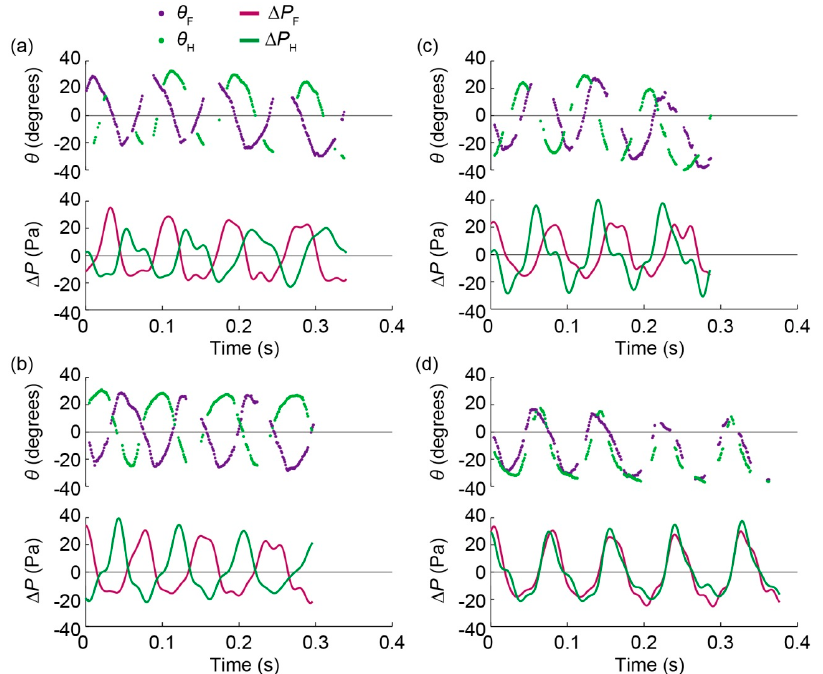
Figure 11. Flapping angles and differential pressures of forewing and hindwing for the four modes: ( a ) forewing-lead; ( b ) counterstroke; ( c ) hindwing-lead, and ( d ) in-phase. These modes correspond to those in Figure 9.